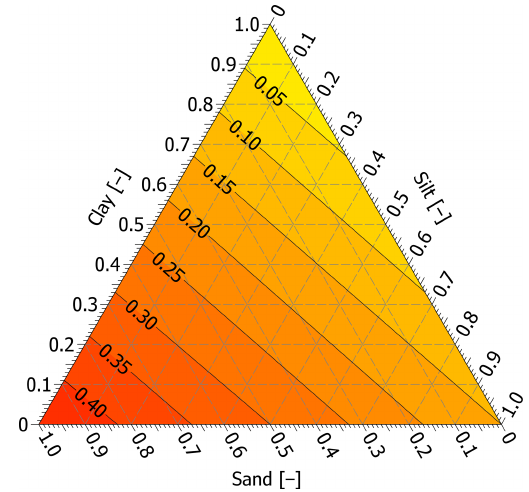
Figure A1. A nomogram for estimating the quartz content using the ground texture based on Johansen (1977). Note that the quartz content (black solid diagonal lines) is obtained at the intersection of the contents of clay, silt, and sand (grey dashed three-way lines) that are read in the direction of their respective tick marks and